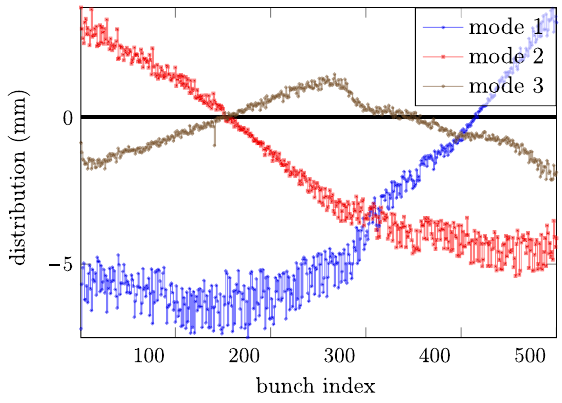
FIG. 7. Distributions of the first three modes along the